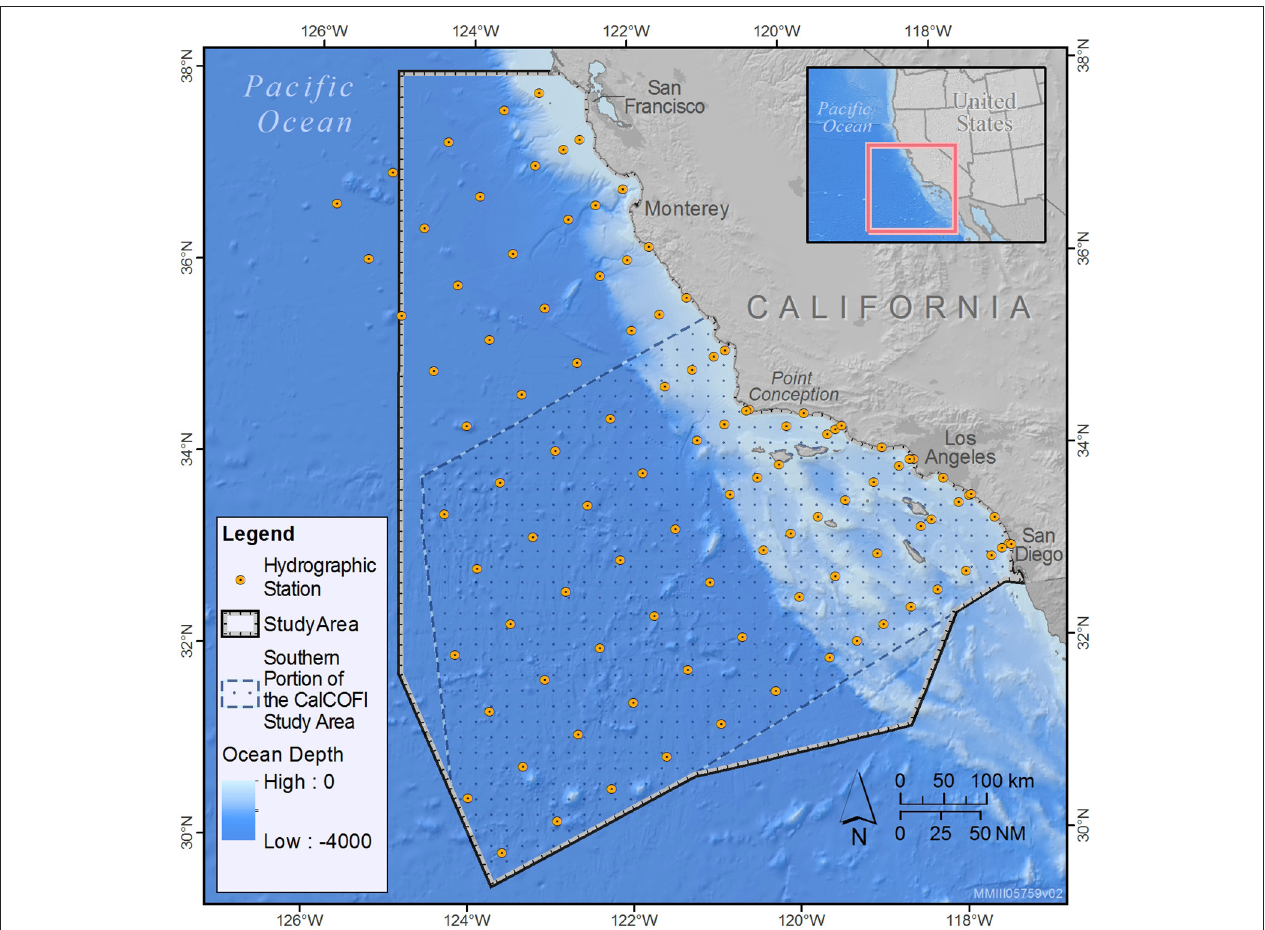
FIGURE 1 | CalCOFI sampling stations (yellow circles) and the approximate 385,460 km 2 study area (black bold line) used to develop the winter/spring species distribution models presented in this study. The study area was clipped at 125 ◦ W longitude to reflect the lack of systematic survey effort west of this line in winter/spring. Also shown is the approximate 238,495 km 2 southern portion of the CalCOFI study area (hashed area encompassed by the dashed blue line) used by Douglas et al. (2014) and Campbell et al. (2015) to develop line-transect density estimates. The southern boundary roughly follows the Unites States/Mexico border and is consistent with that used by Becker et al. (2016) to develop the summer/fall estimates used for comparison in this study.